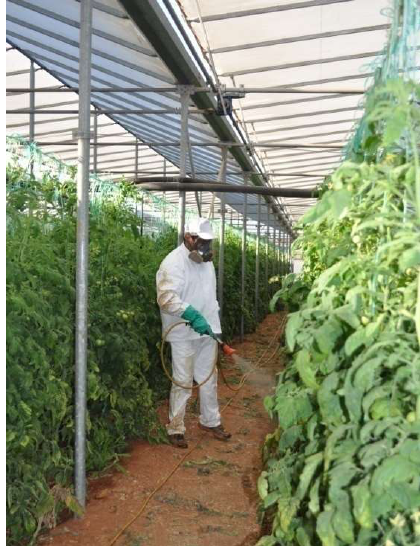
Figure 1. Application of the spray liquid in tomatoes.